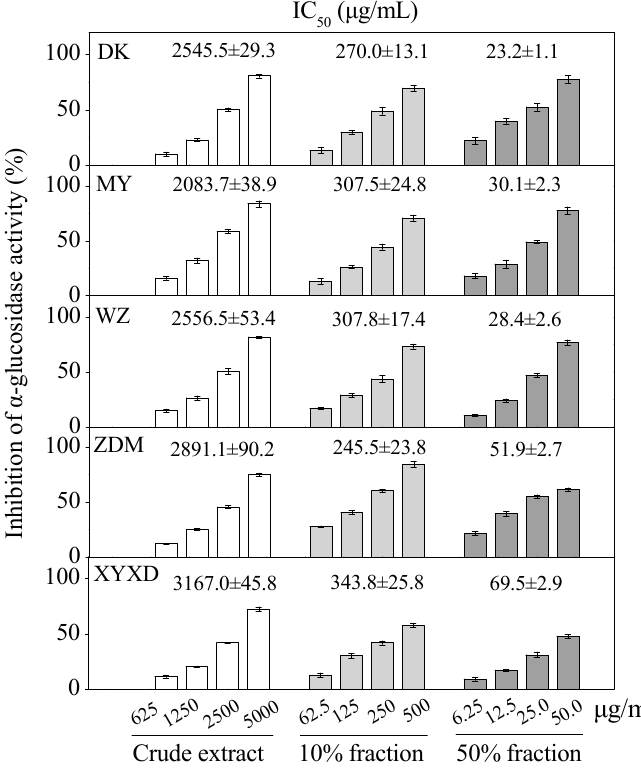
Figure 7. Inhibition of α -glucosidase by crude extract, different fractions from five Chinese bayberry cultivars. IC 50 values are presented as mean ± SD ( n = 3).